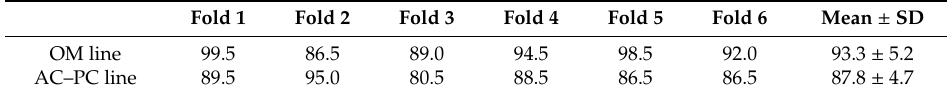
Table 3. Detection rates of the standard line for brain MRI.